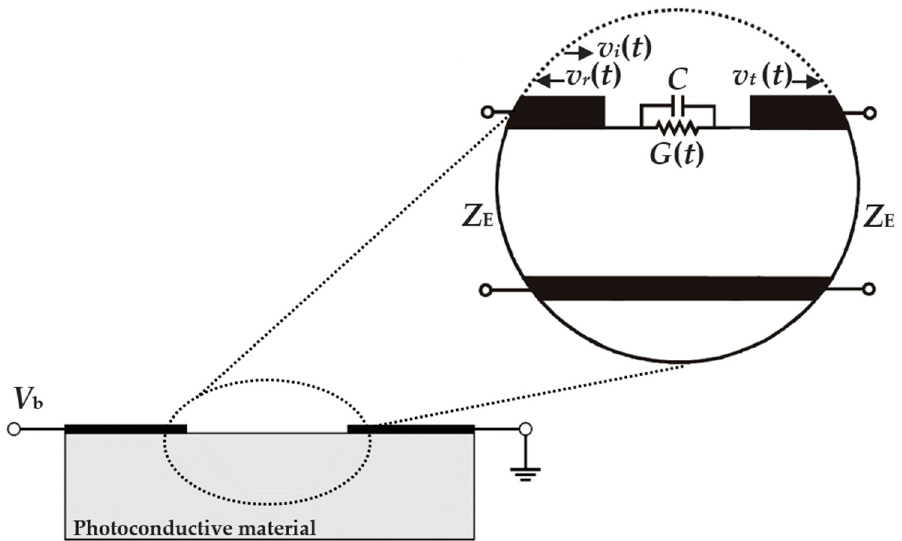
Figure 1. Illustration of the biased PC gap of a PC THz emitter at a bias voltage of V b . The inset shows its equivalent circuit with a gap conductance of G(t ), gap capacitance of C , and electrodes with transient incident, reflected, and transmitted voltage waveforms of v i ( t ), v r ( t ), and v t ( t ), re- spectively.